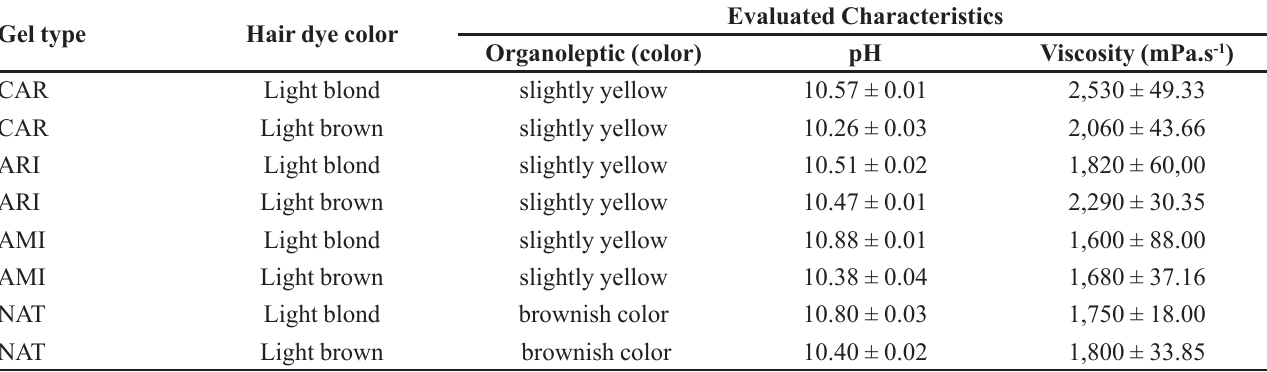
TABLE II - Physic-chemical and organoleptic characteristics of different hair dye color gels types